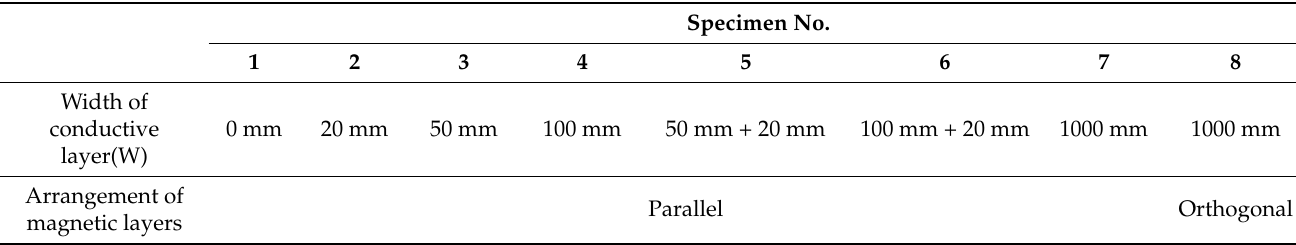
Table 3. Types of specimens.